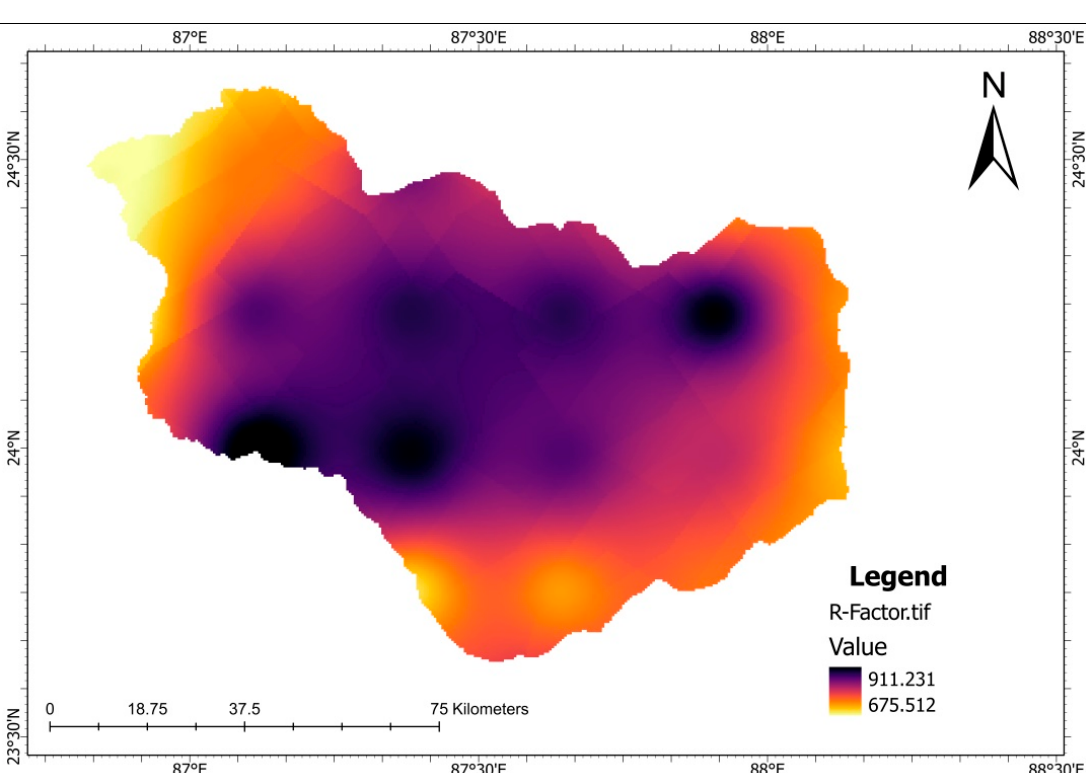
Figure 5. Rainfall Erosivity Factor (R)